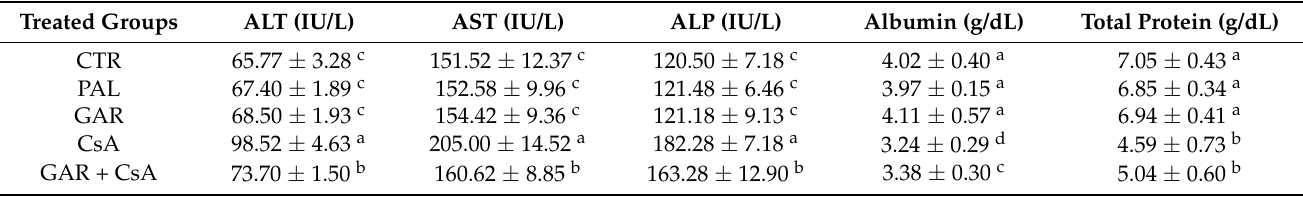
Table 2. Effect of treatment with Cyclosporine (CsA) and/or Garlic on serum levels of ALT, AST, ALP, albumin, and total protein of male Westar albino rats.